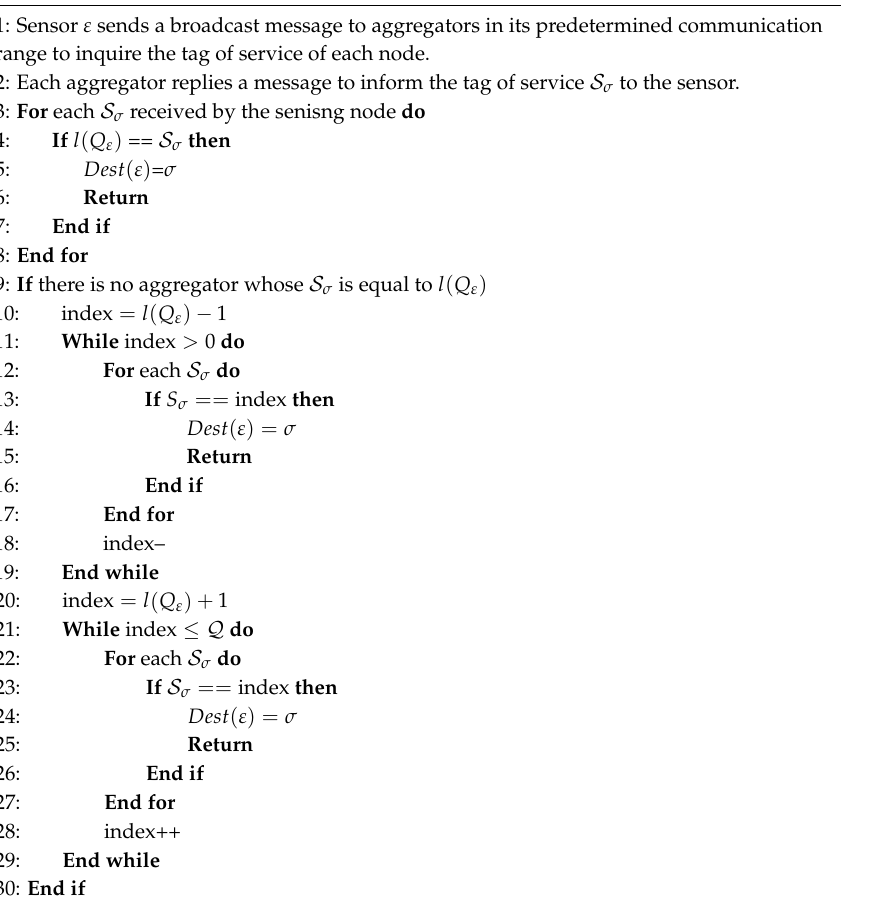
Figure 7. The sample operations in phase 3. Algorithm 2 Establishment of Routing for a Sensor ε